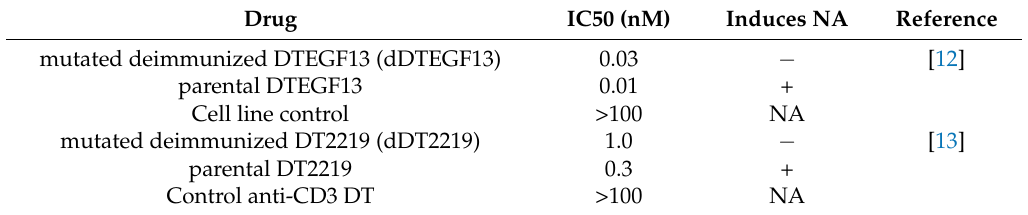
Table 1. DT was deimmunized by replacing 7 key hydrophilic amino acids in DT390 (dDT). Parental DT had no mutations. The DT DNA fragments were used to manufacture dDTEGF13 and dDT2219. dDTEGF13 consisted